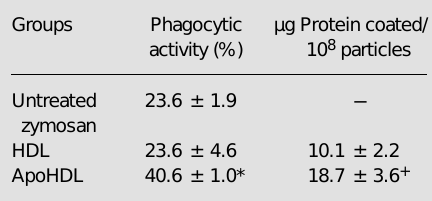
Table 1 - Effect of preincubated zymosan (Zy) particles with intact HDL and apoHDL on their phagocytosis by mouse peritoneal